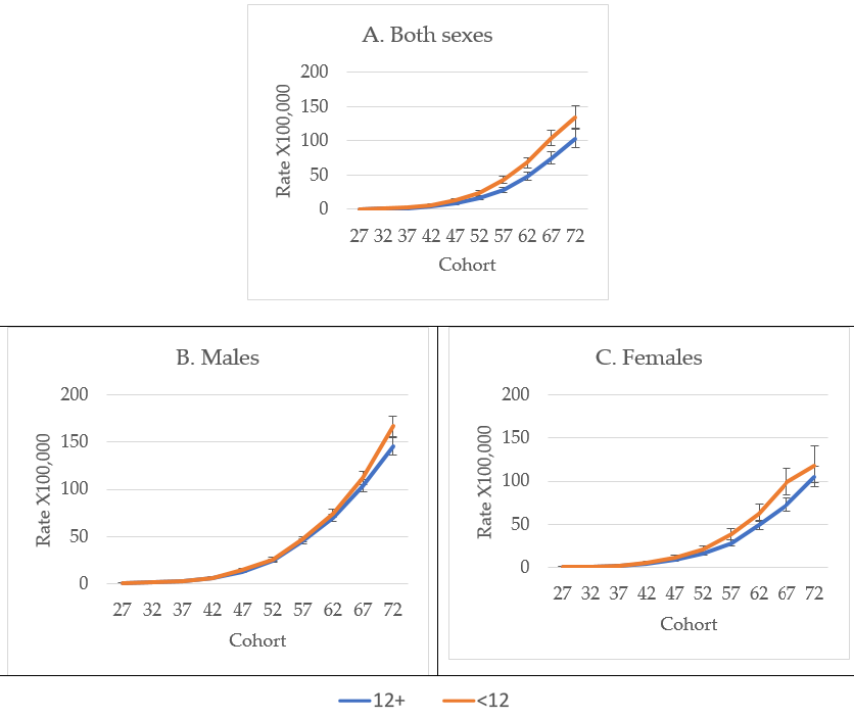
Figure 4. Age- and sex-adjusted diabetes mortality rate among Hispanics in the USA by age, sex, and education level from 1989 to 2018.